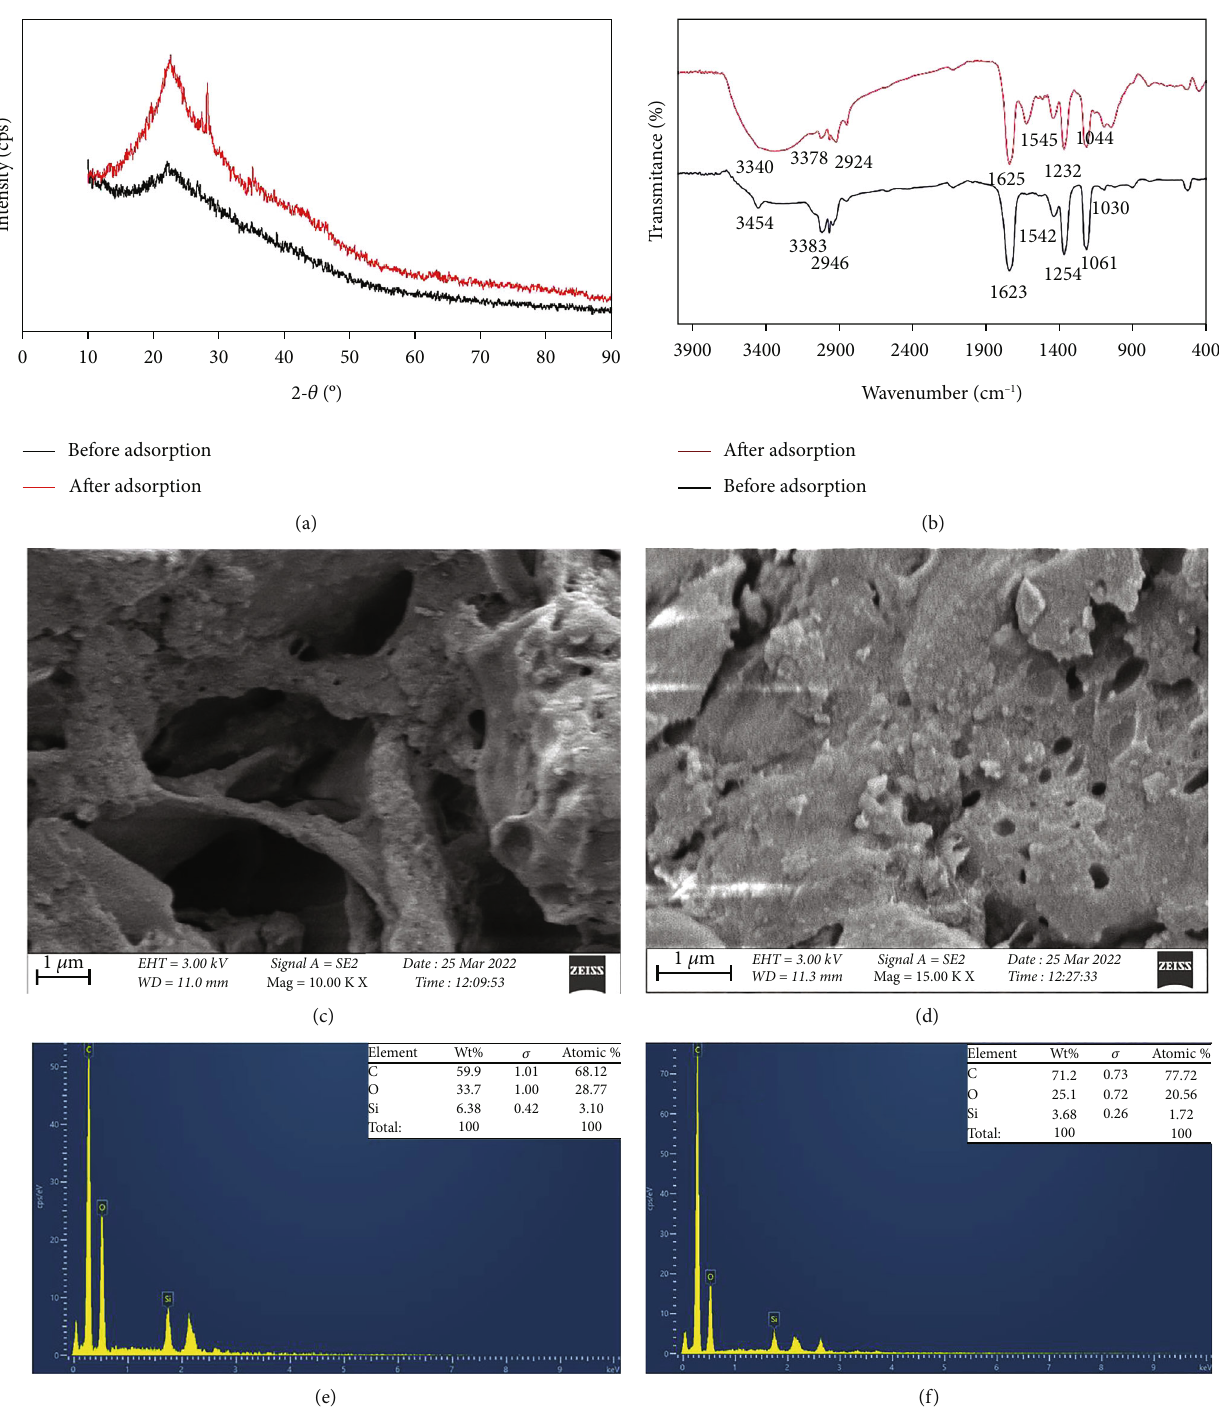
Figure 1: Breadfruit leaf biochar characterization: (a) XRD analysis, (b) FTIR analysis, (c, d) SEM images, and (e, f) EDX spectra of before and after adsorption of Congo red dye,